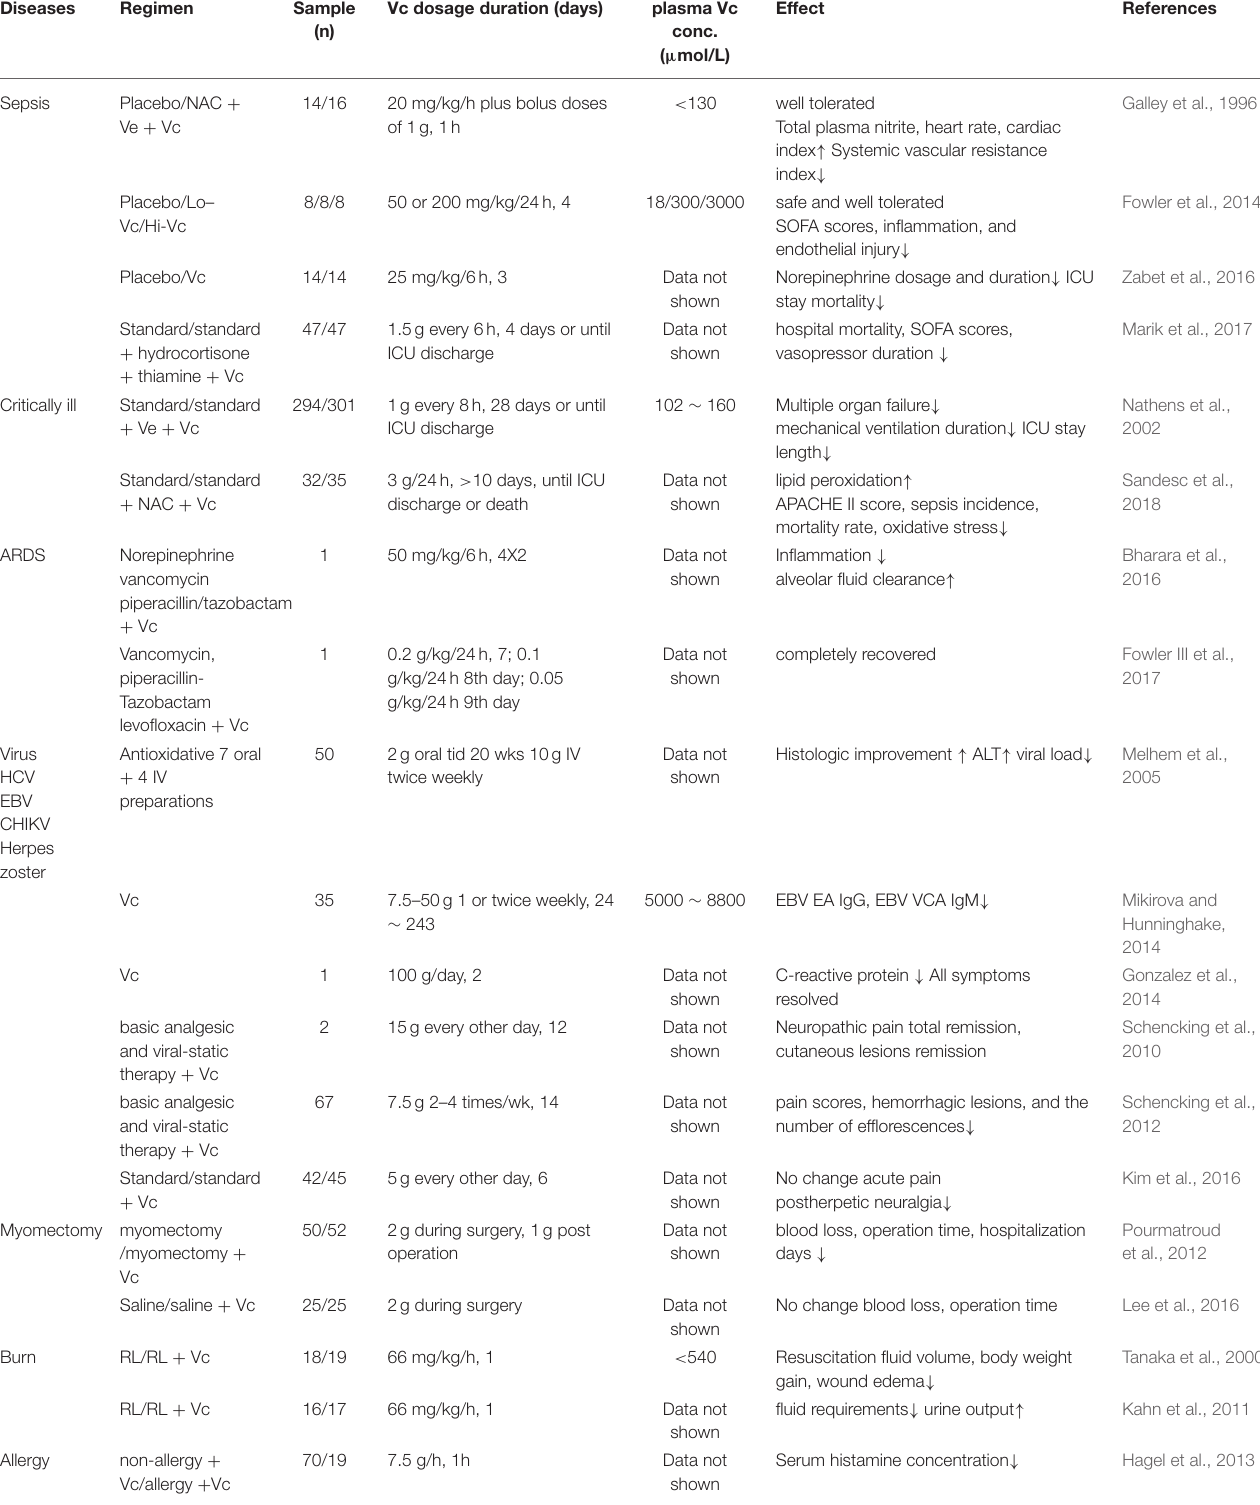
TABLE 5 | Intravenous Vitamin C used in infections, and other diseases.